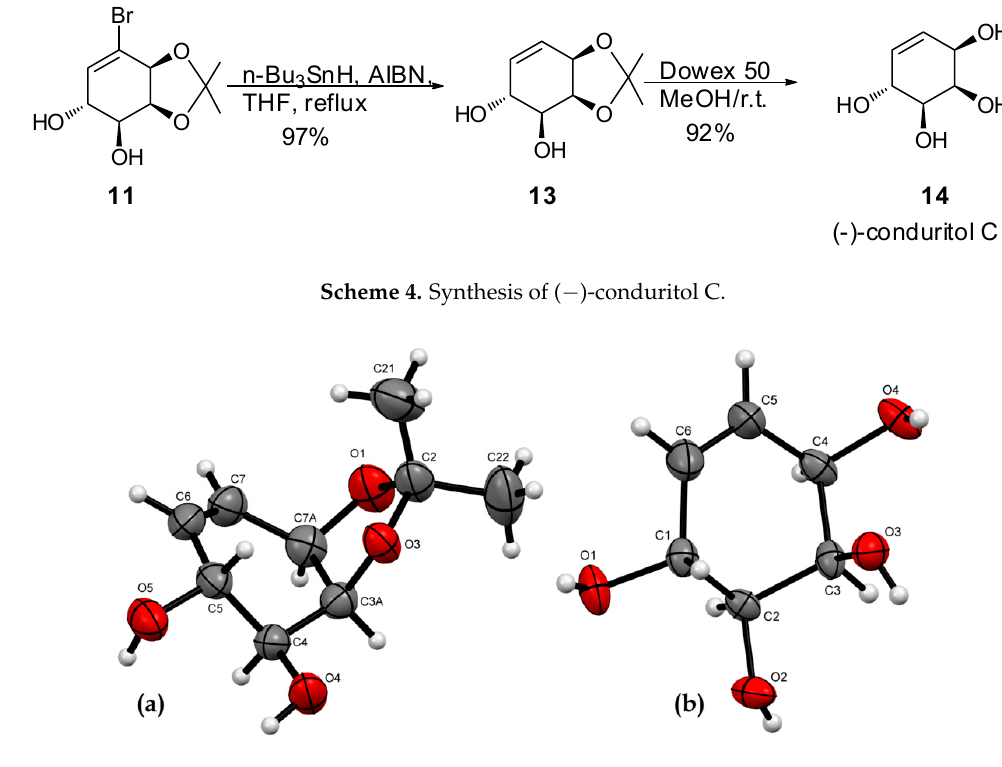
Figure 3. ORTEP plots of ( a ) conduritol C acetonide ( 13 ), and ( b ) ( − )-conduritol C ( 14 ).